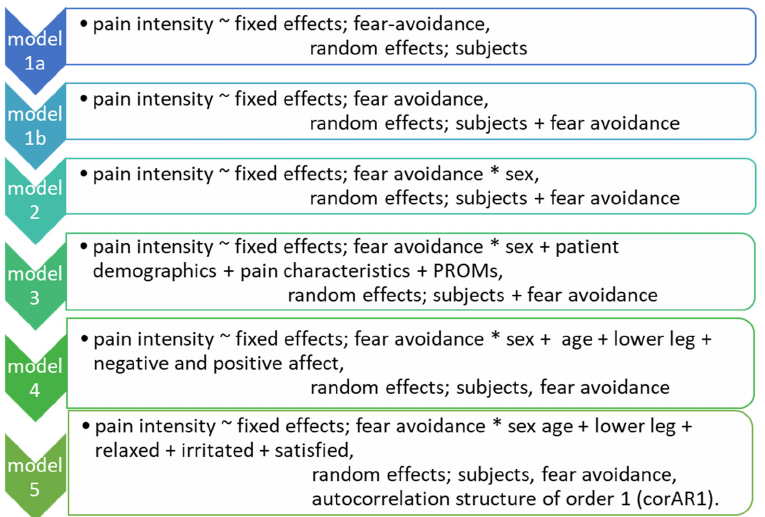
Figure 1. Construction of linear mixed-effects model applied to the data. ~ Separation of the dependent and independent variables. * Indicative of an interaction term and the original variables themselves. Table 1. Baseline description of the chronic pain patient cohort.